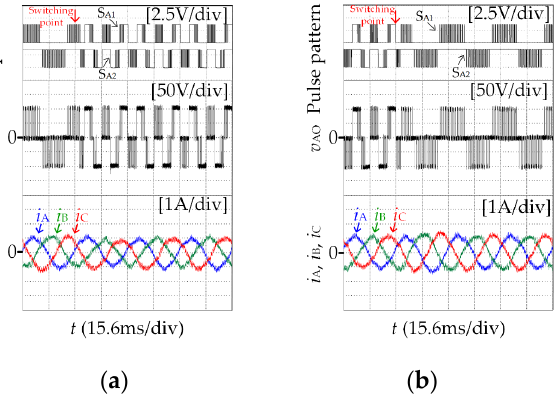
Figure 10. Experimental results of asynchronous modulation and SSVM_15(IV) switching. ( a ) Asynchronous modulation → SSVM_15 (IV). ( b ) SSVM_15 (IV) → asynchronous modulation.